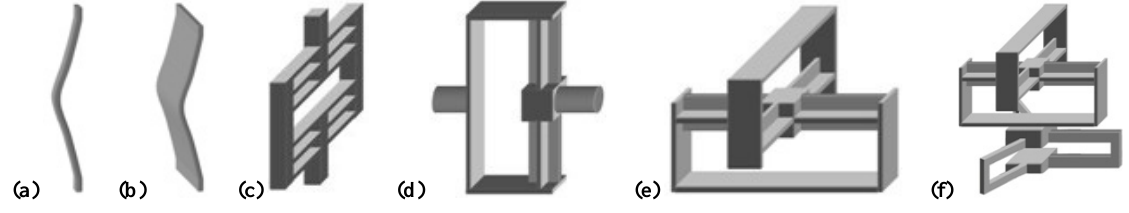
Figure 3. Flexures with distributed compliance. The flexures could be a (a) pin, (b) chevron, (c) translational, (d) rotational, (e) universal, or (f) spherical flexure. Reproduced from Gallego and Herder (2009).